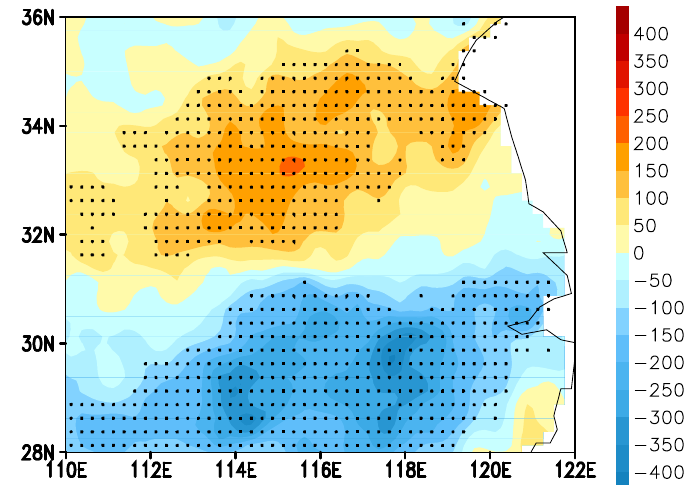
Figure 4. Composite difference of summer mean total rainfall amount (TRA; unit: mm) over eastern China between the periods 1990–1999 and 2000–2009. Significant anomalies at the 90% confidence level are stippled with black dots.